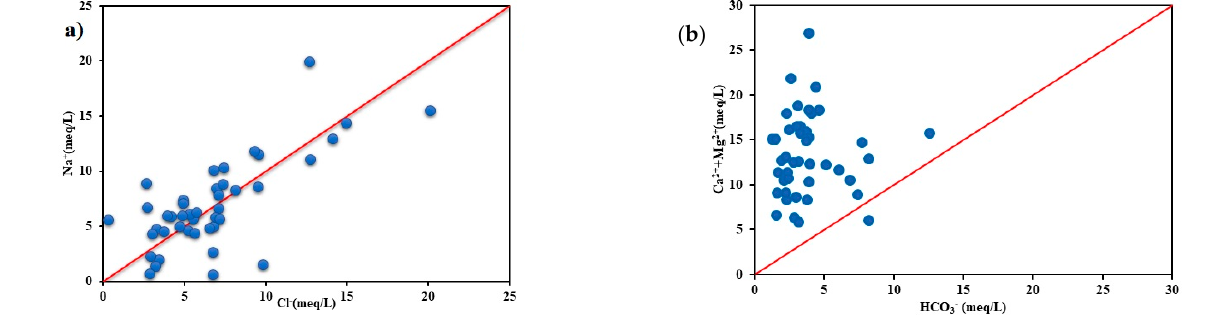
Figure 9. Ionic relationships of ( a ) Na + vs. Cl − and ( b ) (Ca 2+ +Mg 2+ ) vs. HCO 3 − . The ionic bivariate diagram of Ca 2+ +Mg 2+ vs. HCO 3 − helps to represent how rock shows that 98% of the sample locations were above the 1:1 equiline of Ca 2+ +Mg 2+